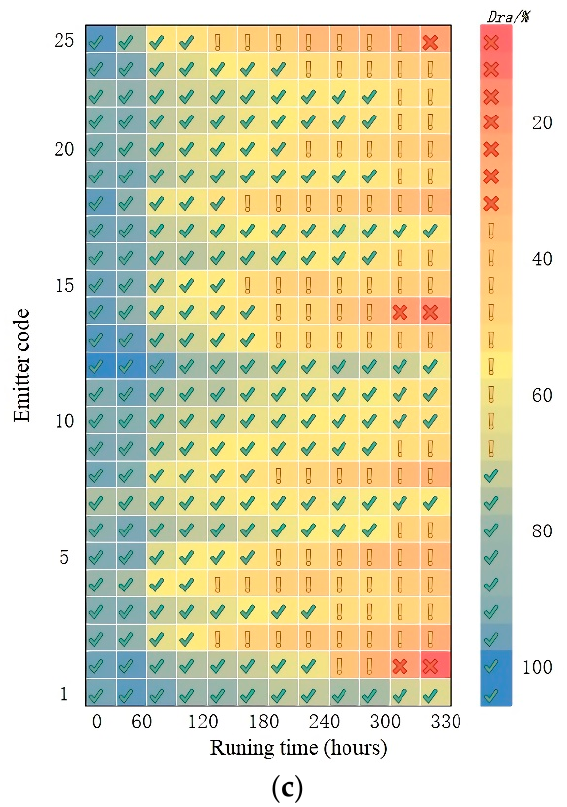
Figure 4. Distribution diagram of the emitter Dra with the change in filling time under different filling modes. ( a ) UAI; ( b ) VAI; ( c ) MAI.